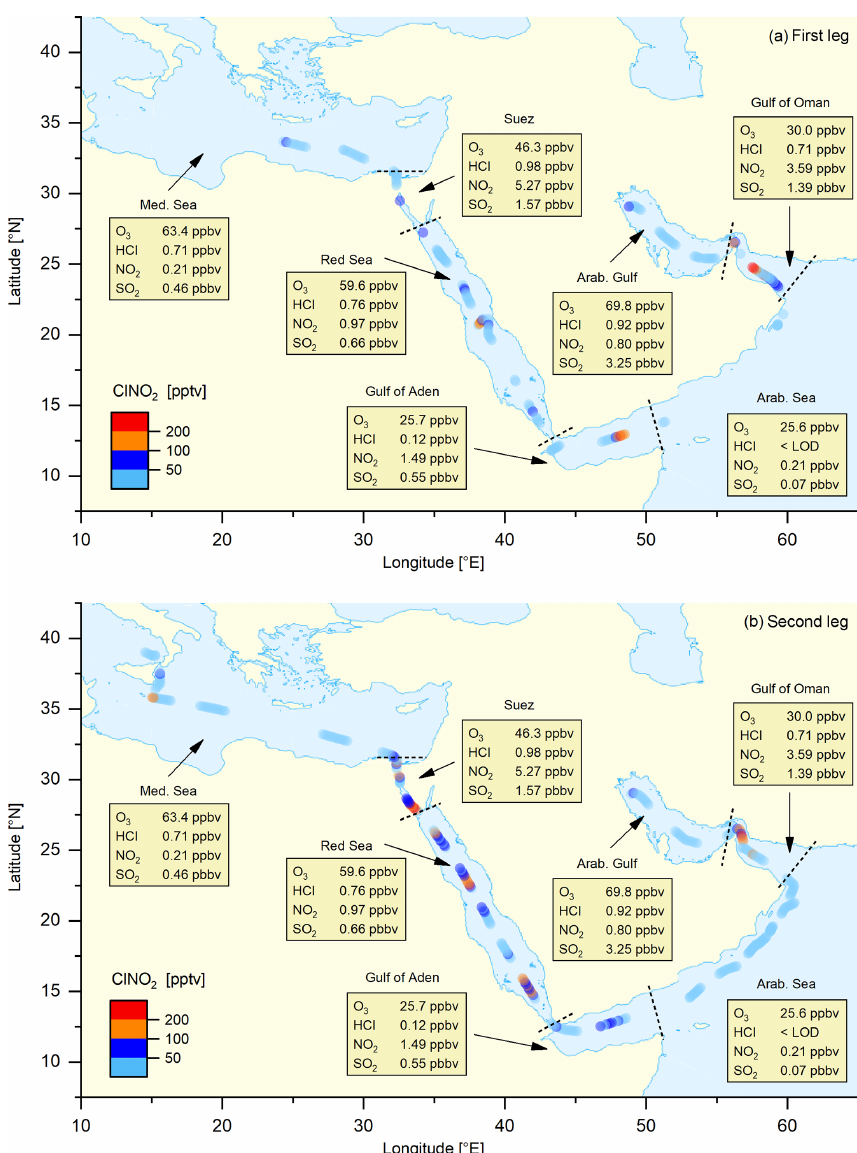
Figure 2. Map of nocturnal ClNO 2 mixing ratios (1h averages) for the (a) first and (b) second legs, together with (median) night-time mixing ratios of O 3 , HCl, NO 2 , and SO 2 for different regions (data from both legs combined) demarked by the dashed lines.